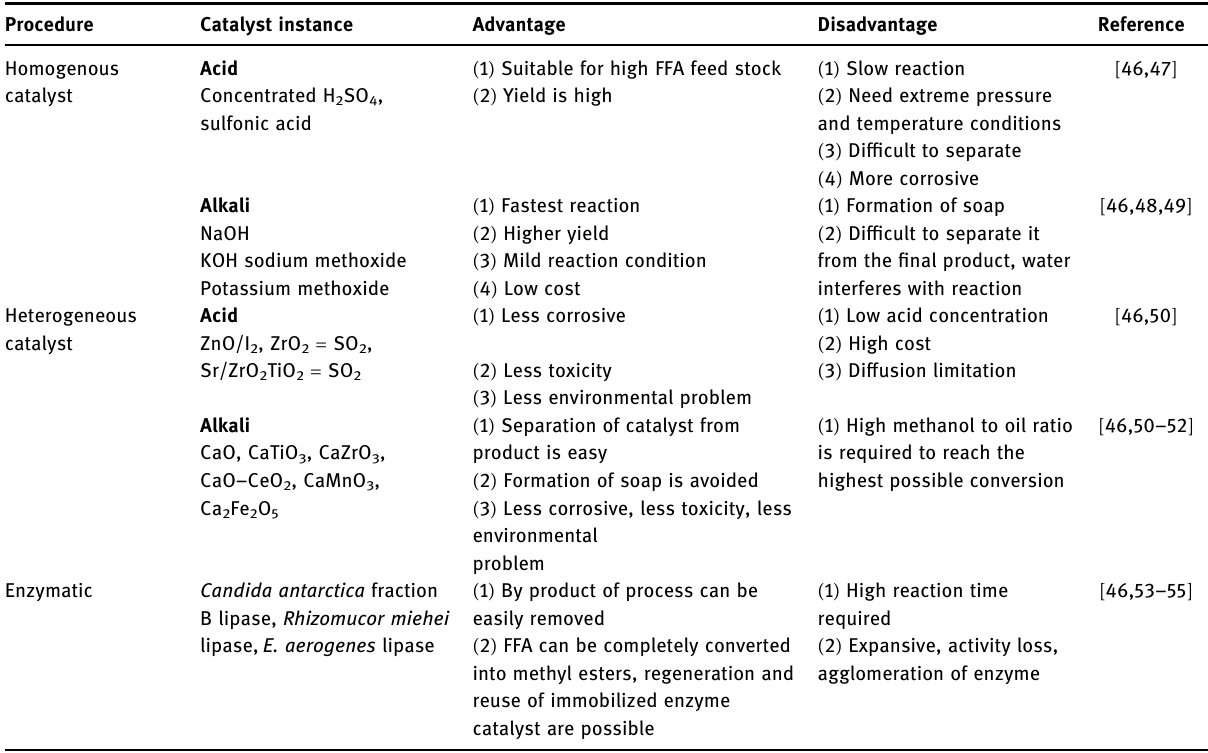
Table 2: Various procedures for biodiesel production from WCO through transesteri fi cation Procedure